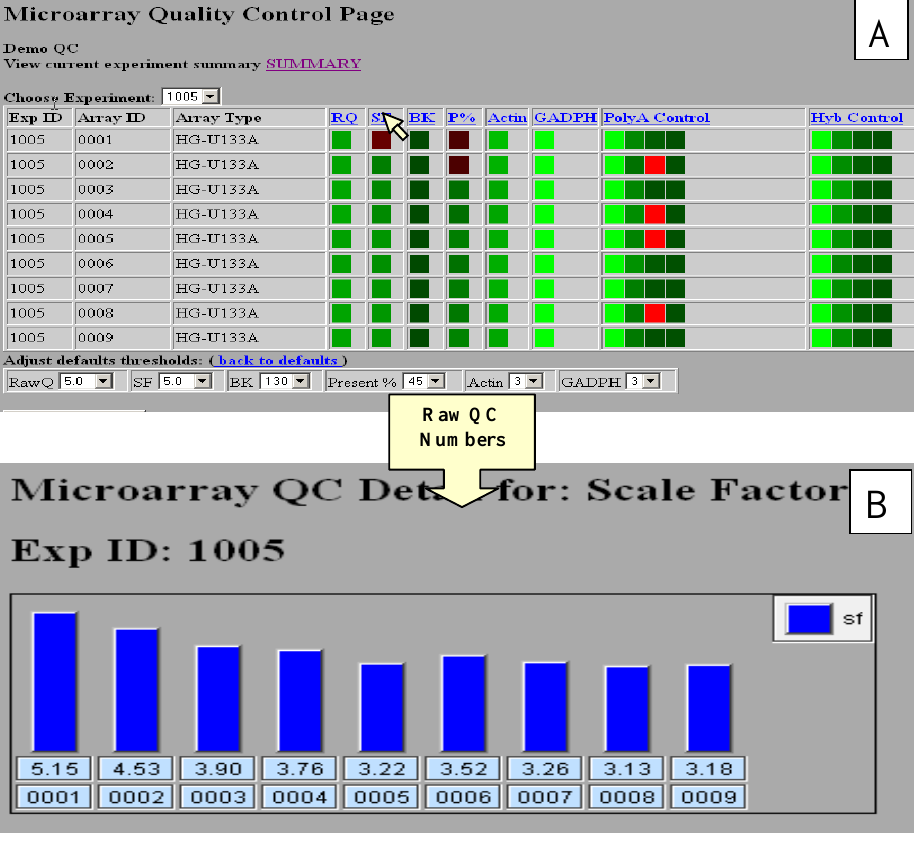
Figure 5: Flowchart of Goober web interface for real-time